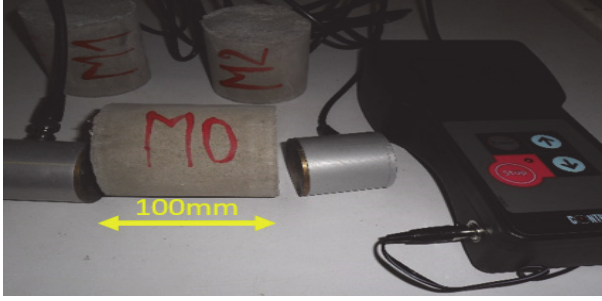
Figure 2: Test on dynamic modulus of elasticity of SCRMs